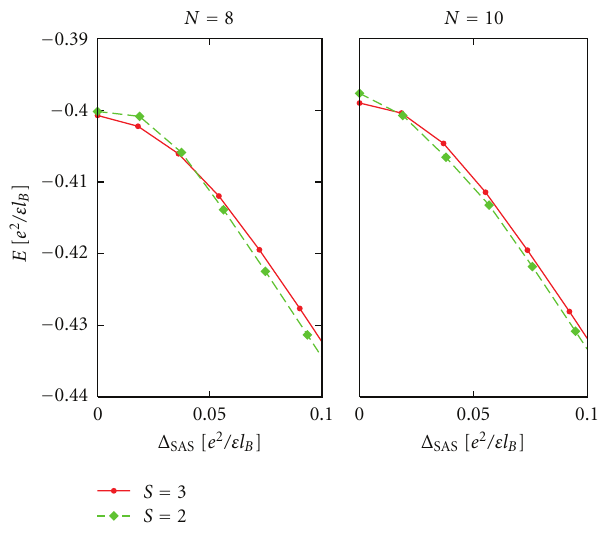
Figure 1: (color online) Ground state energies on the sphere as a function of tunneling for the filling factor ν T = 1 / 2 and the shifts S = 3 and S = 2. We show data for N = 8 and N = 10 electrons and the distance is fixed at d = l B .